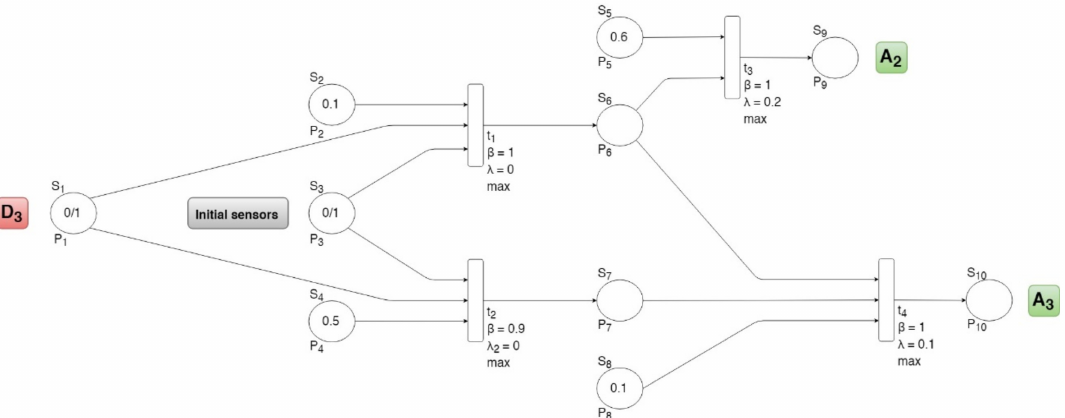
Figure 9. A graphical structure of the fuzzy Petri net algorithm for the transition between production despite the failure (D3) and requested stop at the end of the cycle (A2) or a requested stop (non-initial state) A3 of the GEMMA